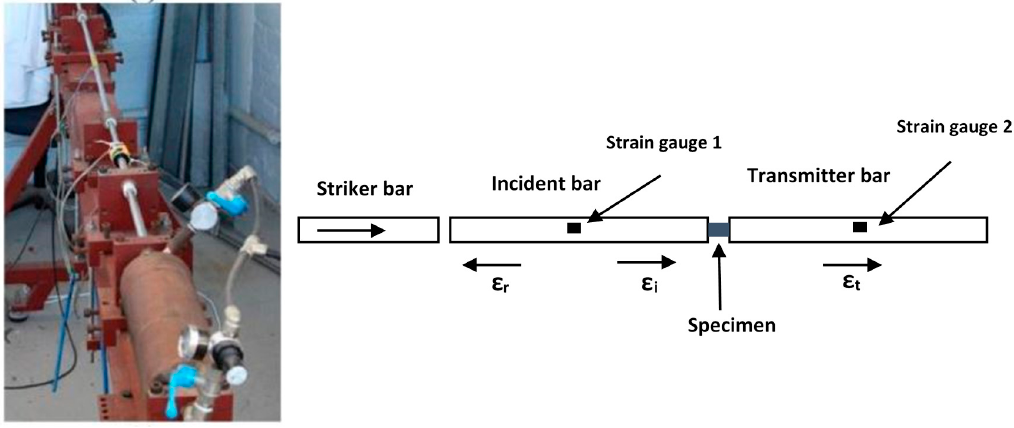
Figure 1. The SHPB compression test setup, reproduced from [29], with permission from Elsevier,